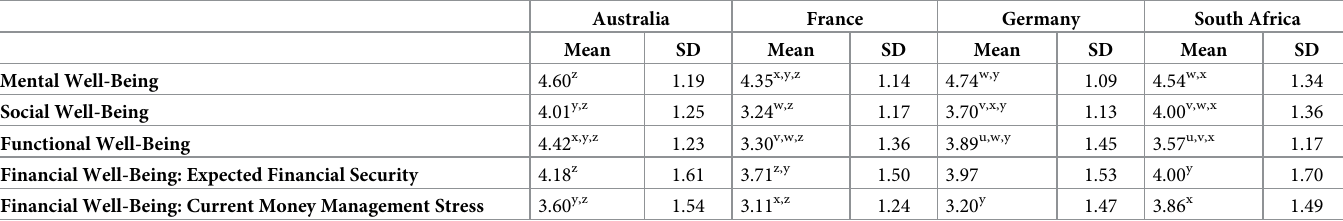
Table 5. Differences in survey respondents’ well-being across Australia, France, Germany and South Africa during the COVID-19 pandemic.